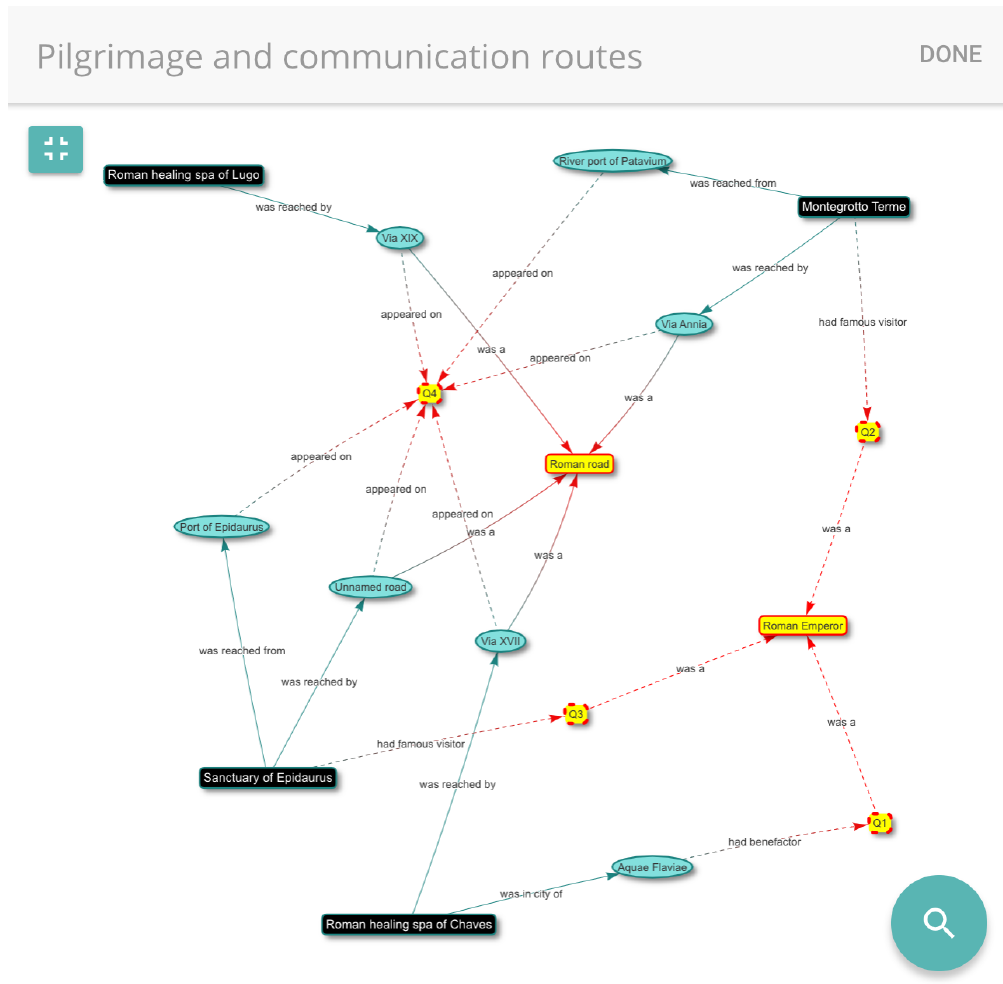
Figure 5. A mesh of associations and questions related to a reflective